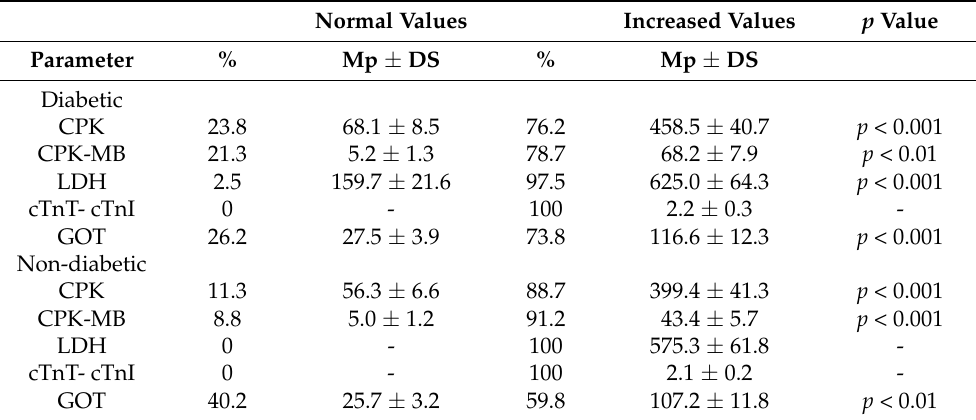
Table 4. Enzymes of myocardial